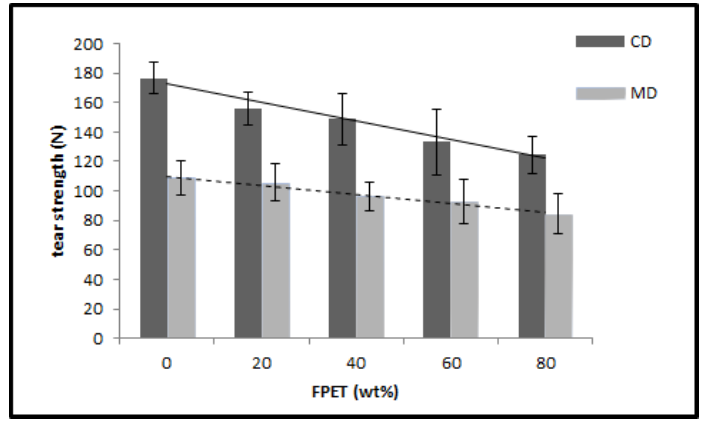
Figure 3. Tear strength of nonwoven fabrics in relation to the content of FPET.